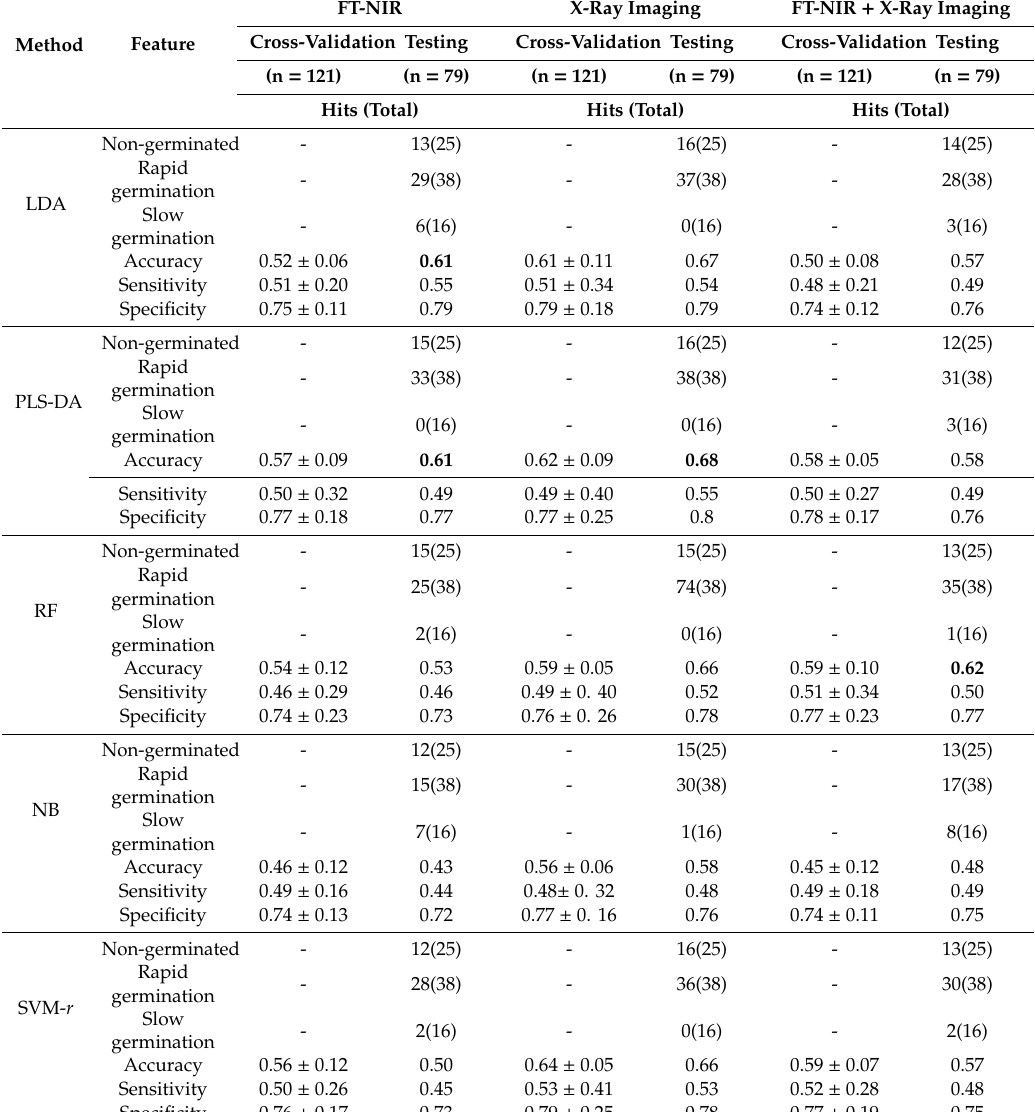
Table 3. Number of seeds correctly classified for di ff erent vigor classes using descriptors generated by Fourier transform near-infrared (FT-NIR) spectroscopy, X-ray imaging, and the combination of FT-NIR spectroscopy and X-ray